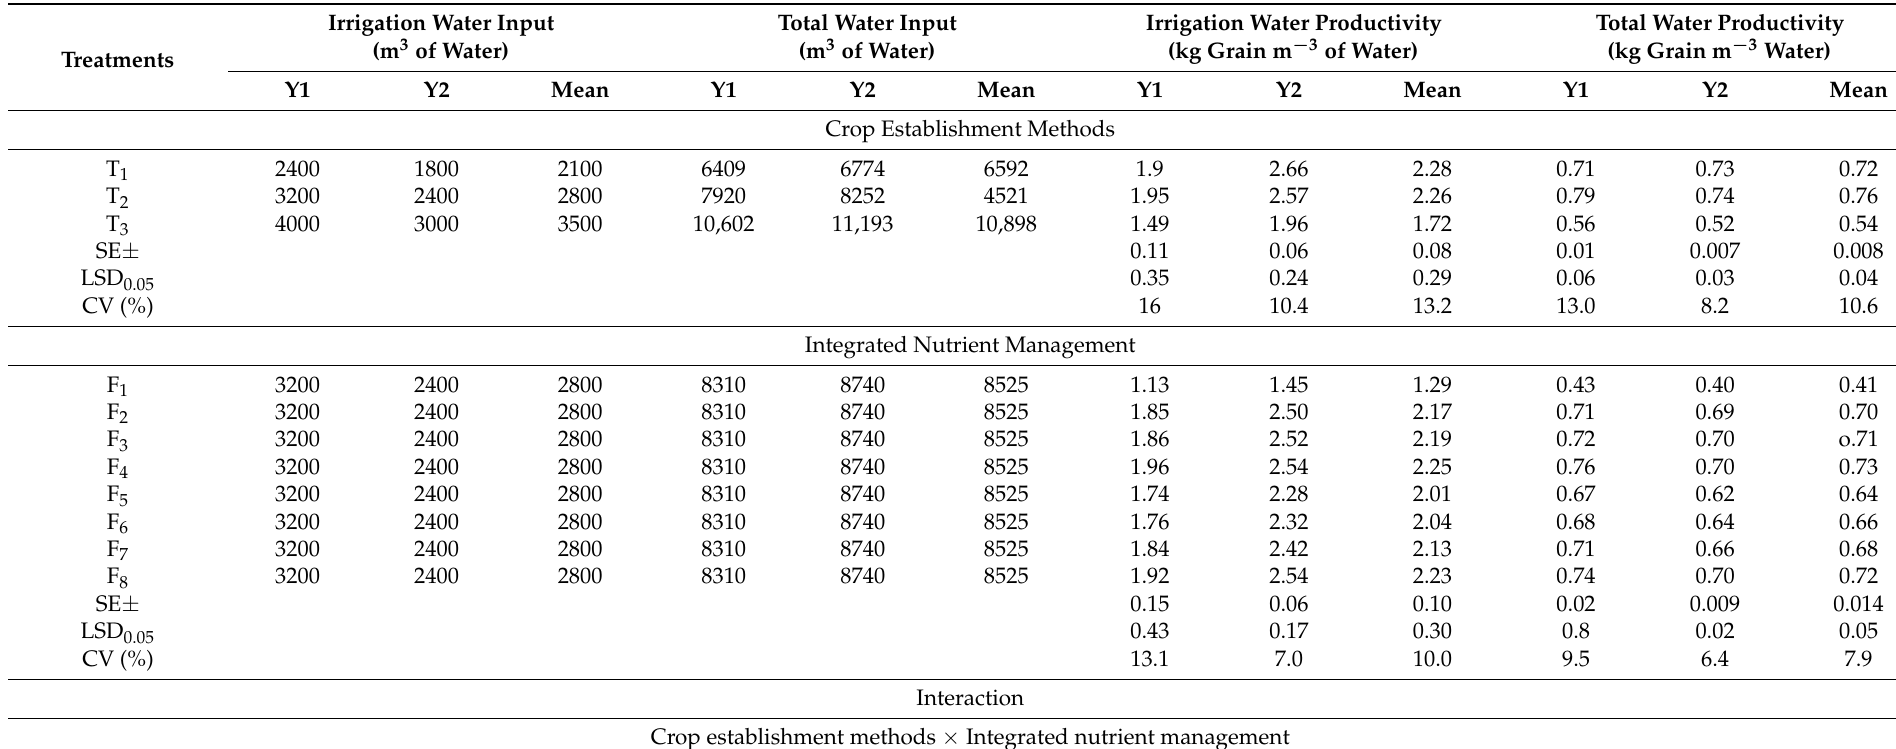
Table 5. Crop establishment methods and integrated nutrient management influenced the irrigation water input and water productivity of rice.